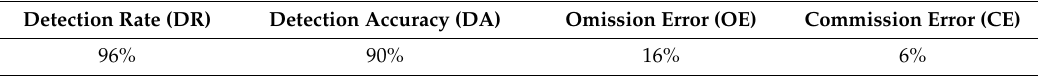
Figure 9. Individual tree detection (ITD) results: ( a ) ITD vector layer over a PNOA orthophoto [56]; ( b ) ITD vector layer over the CHM 2 m raster layer. Table 8. Summary of accuracy assessment results for individual tree detection.